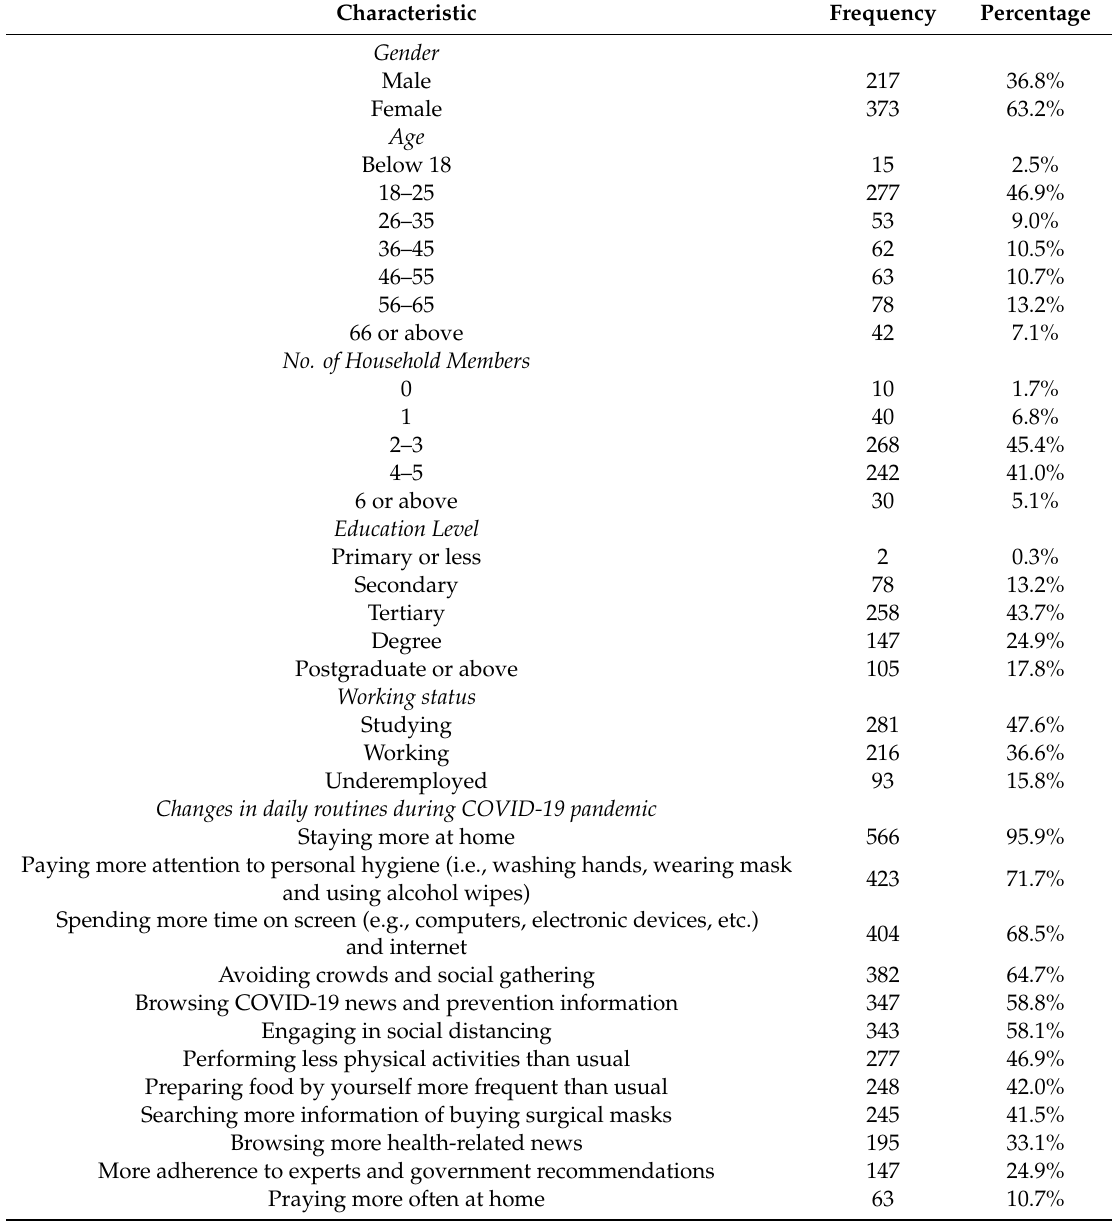
Table 1. Characteristics of study